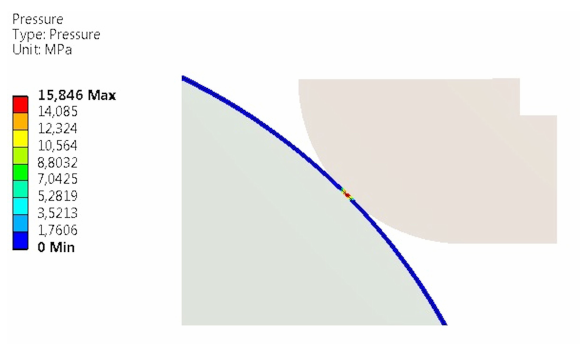
Figure 7: The contact stress distribution between the ball and seal variant 2